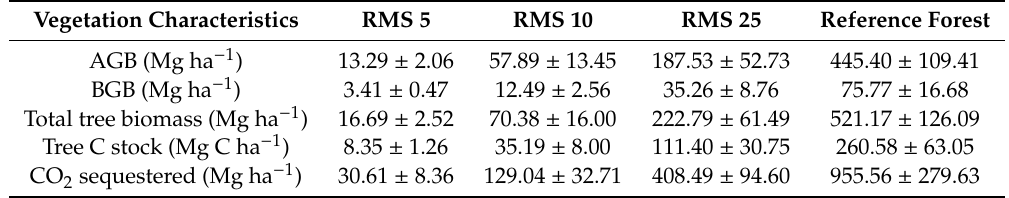
Table 1. Vegetation characteristics and accumulation of biomass carbon in a ff orested chronosequence dumps and reference forest (mean ± SE, n =